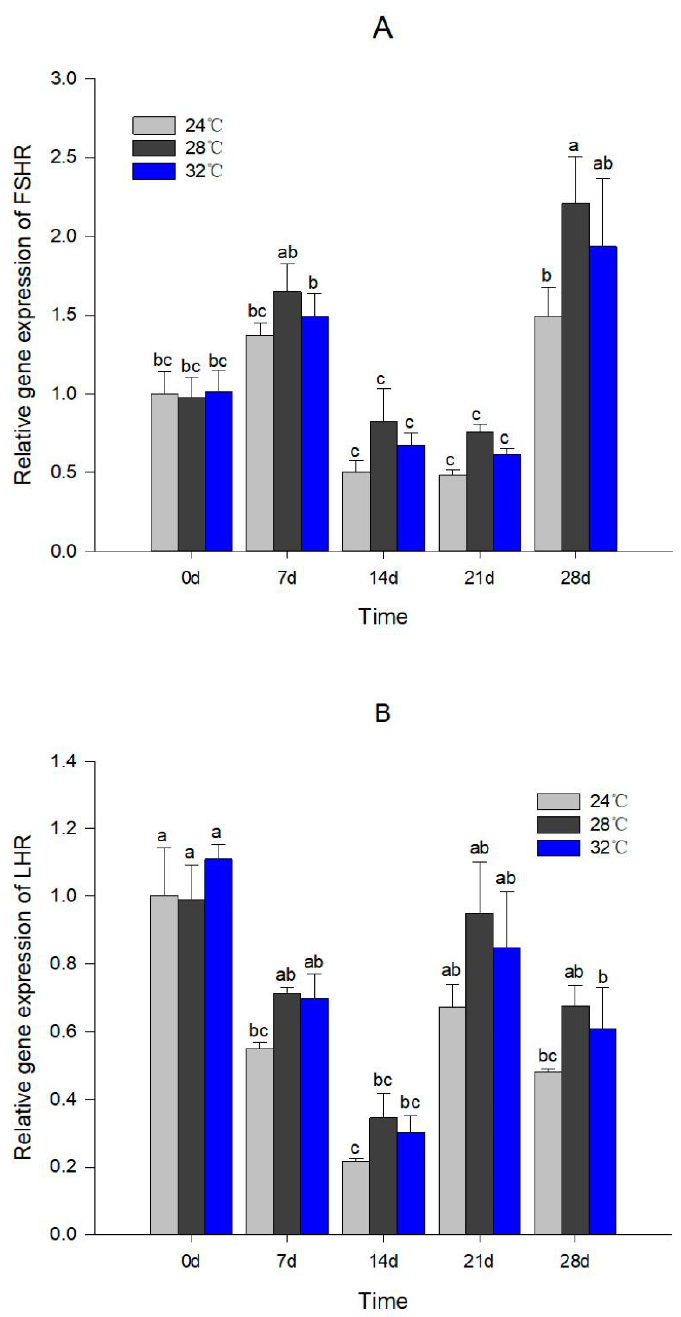
Figure 3. Expression analysis of FSHR gene ( A ) and LHR gene ( B ) in the ovary after different temperature treatments. Note: Different lowercase letters represent significant differences between the experimental groups at various time points ( p < 0.05); Reference gene: β-actin ; n = 3.